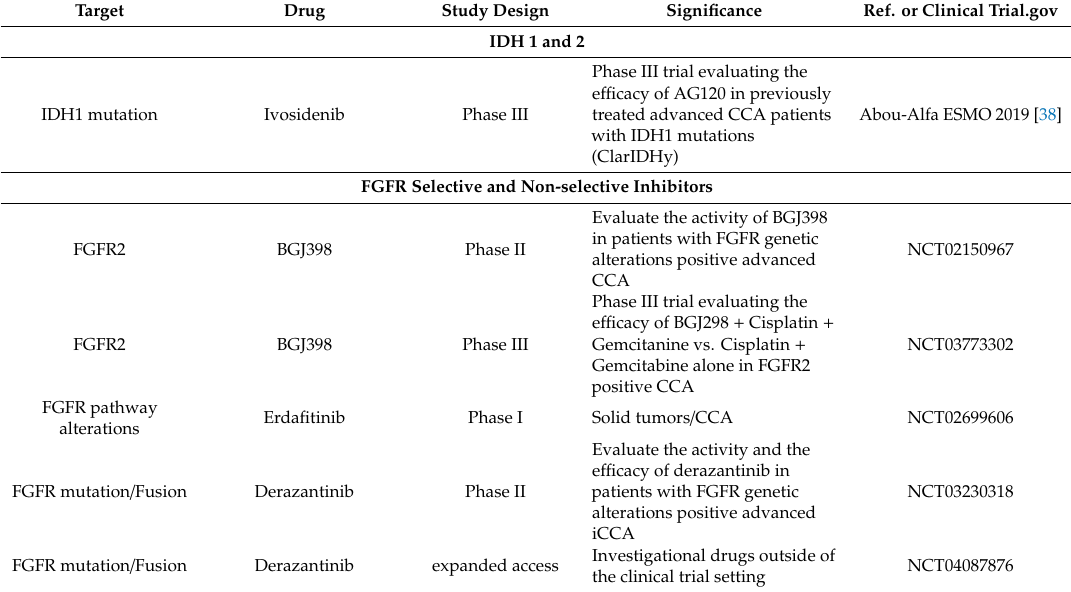
Table 2. Target agents in clinical